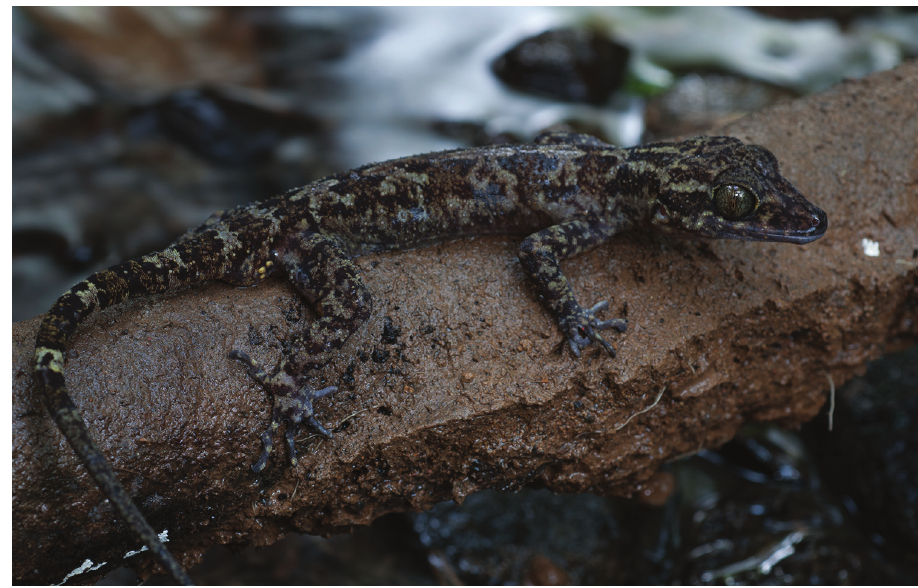
Figure 48. Cyrtodactylus mamanwa male (KU 305564) from Municipality of Loreto, Dinagat Island. Photo: